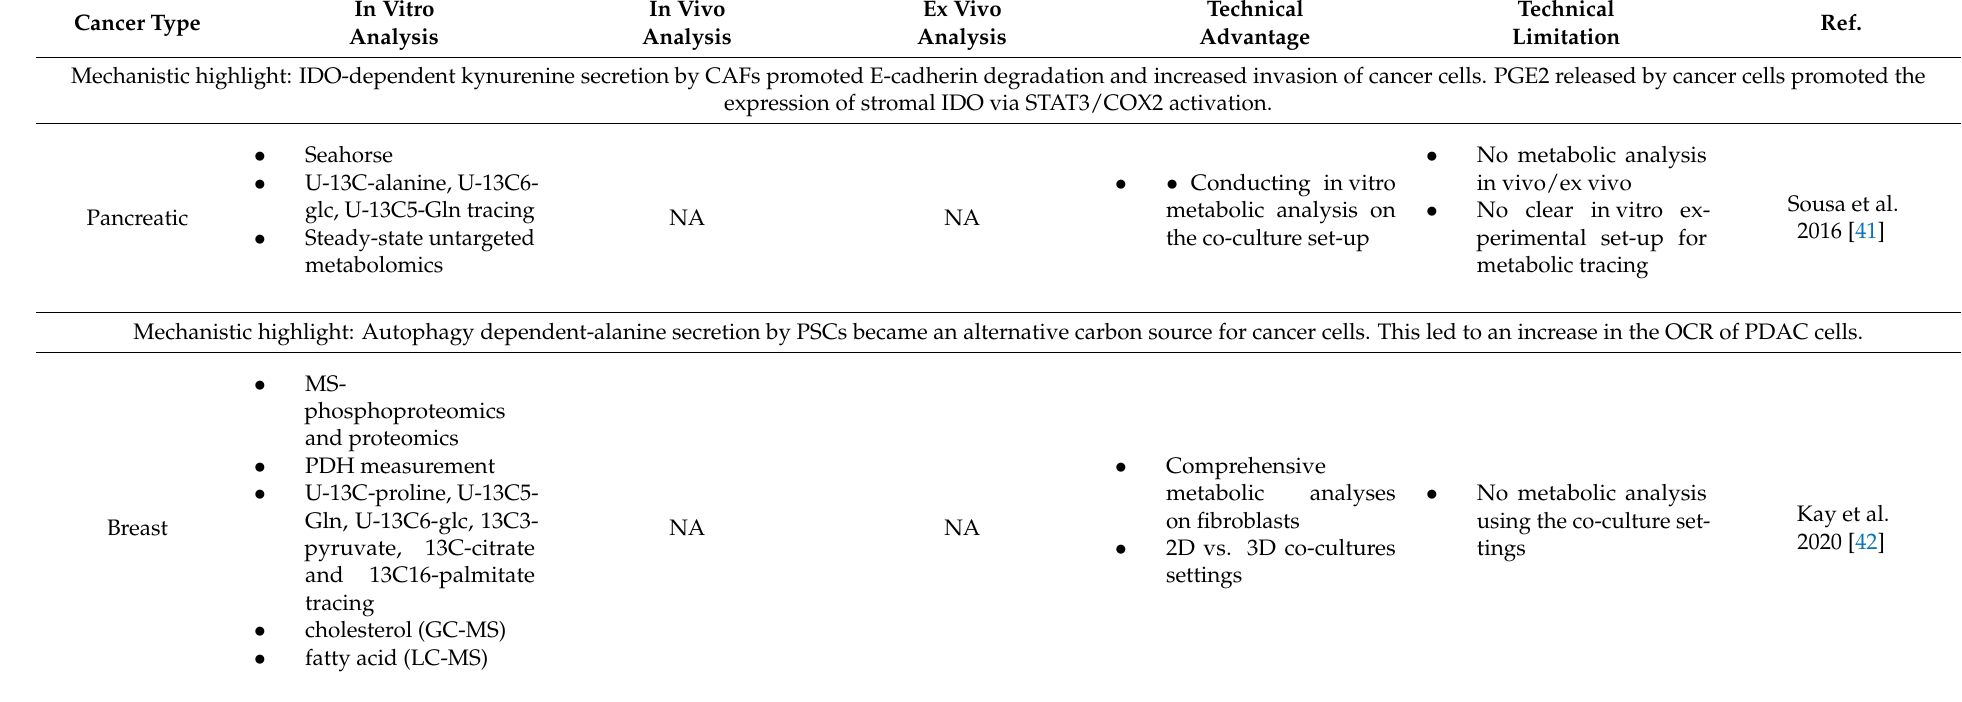
Technical Limitation